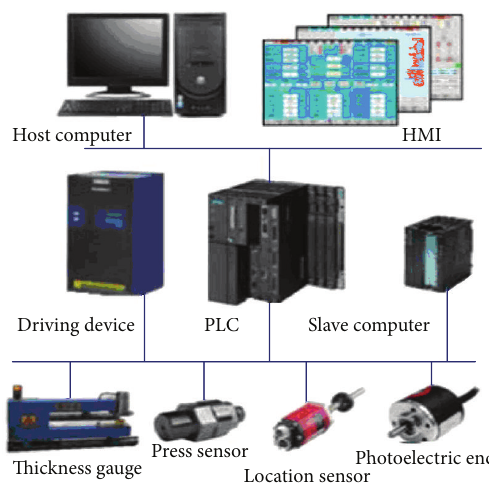
Figure 8: The main coiling equipment and hardware configuration of control system.